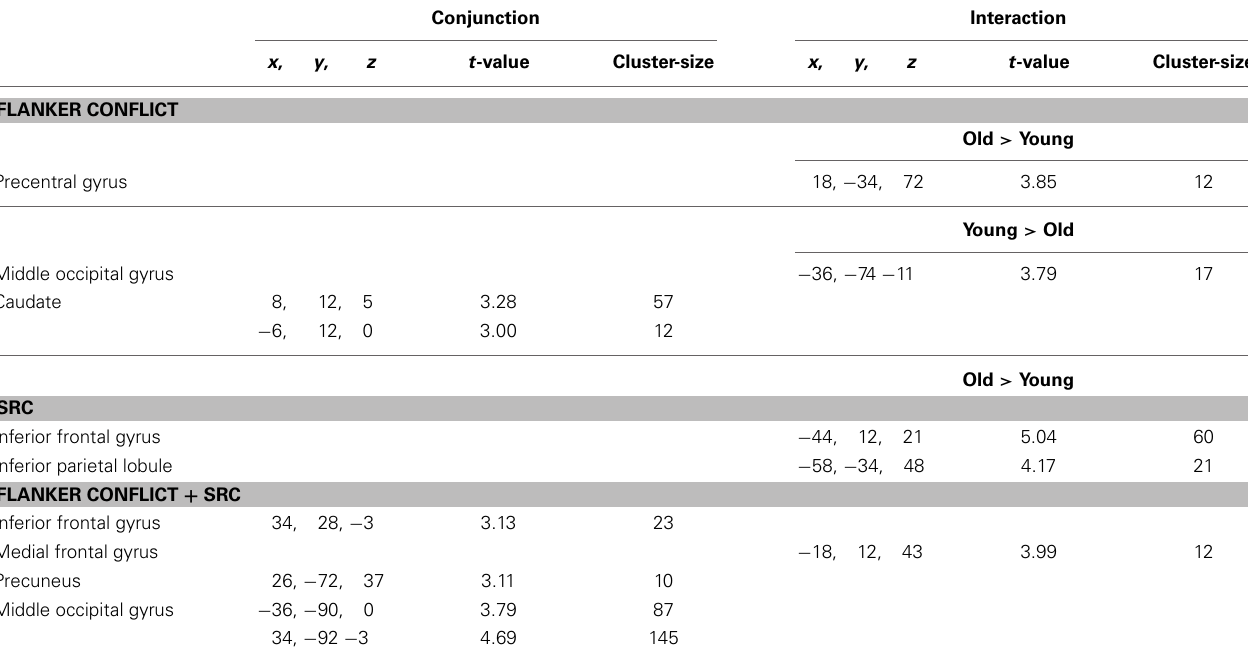
Table 3 | Peak activations derived from a conjunction analysis [intermediate null hypothesis, p < 0 . 005 (uncorrected), k = 9] and an interaction analysis ( p < 0 . 001, uncorrected, k = 9) of the Flanker [fisc > fcsc], SRC [fcsi > fcsc], and double conflict (Flanker + SRC) [fisi > fcsc] contrasts.